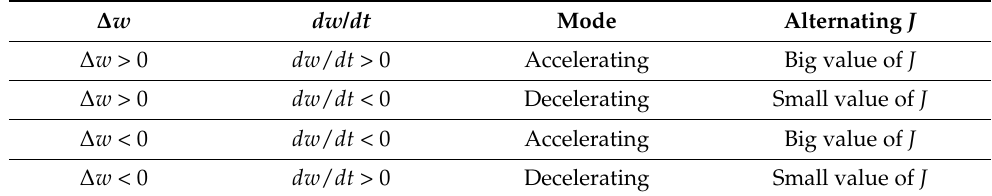
Table 3. Power oscillation modes.